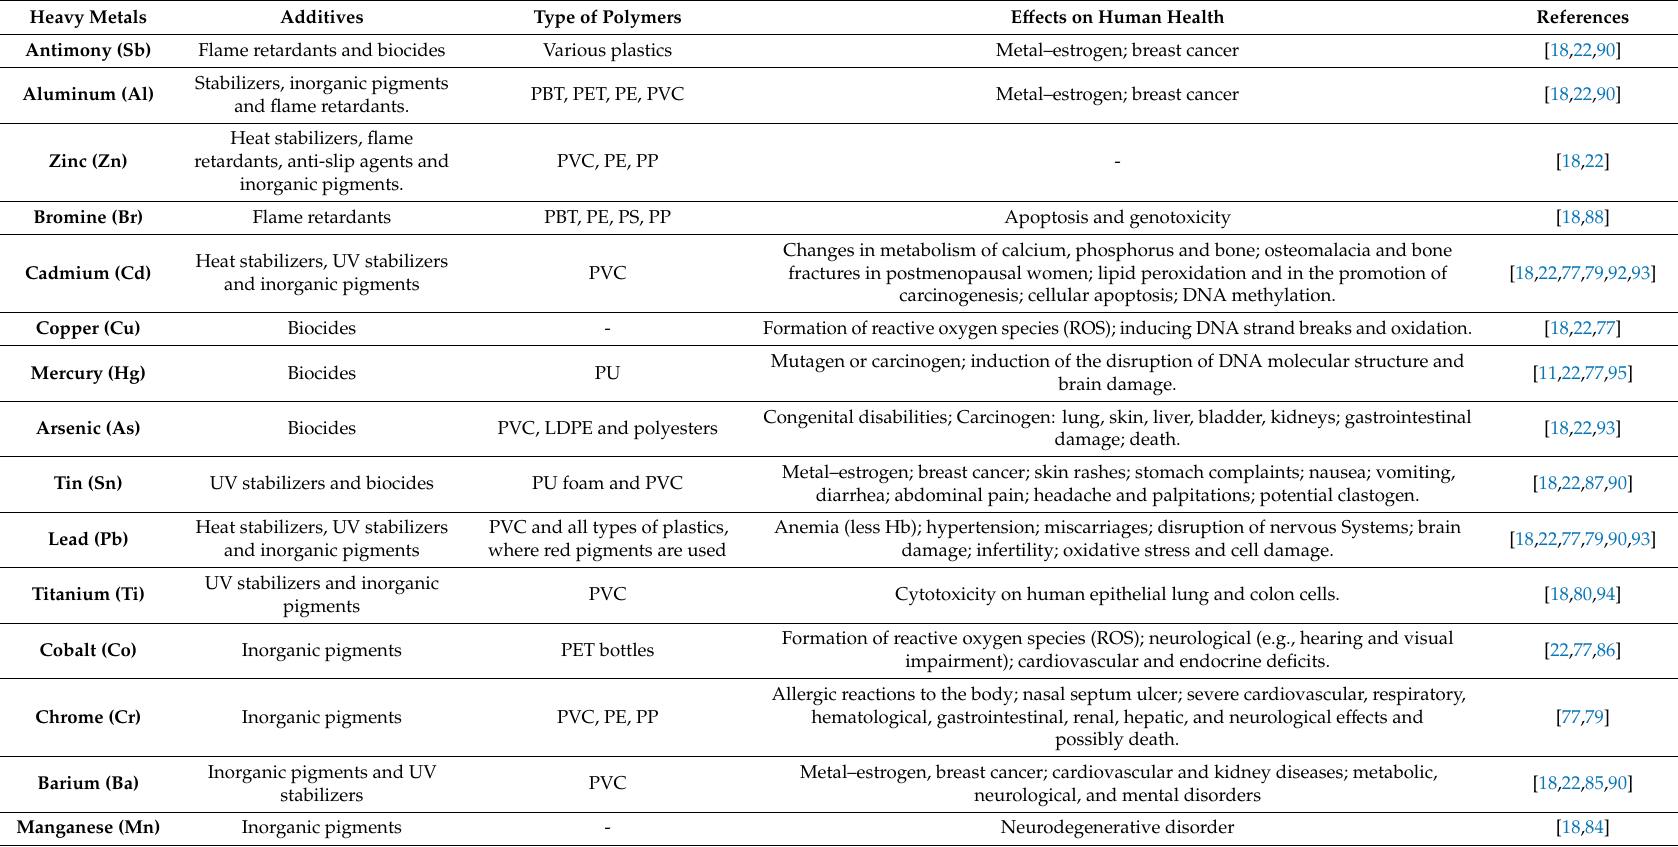
Table 1. Main use of heavy metals as additives in polymer products and their e ff ects on human